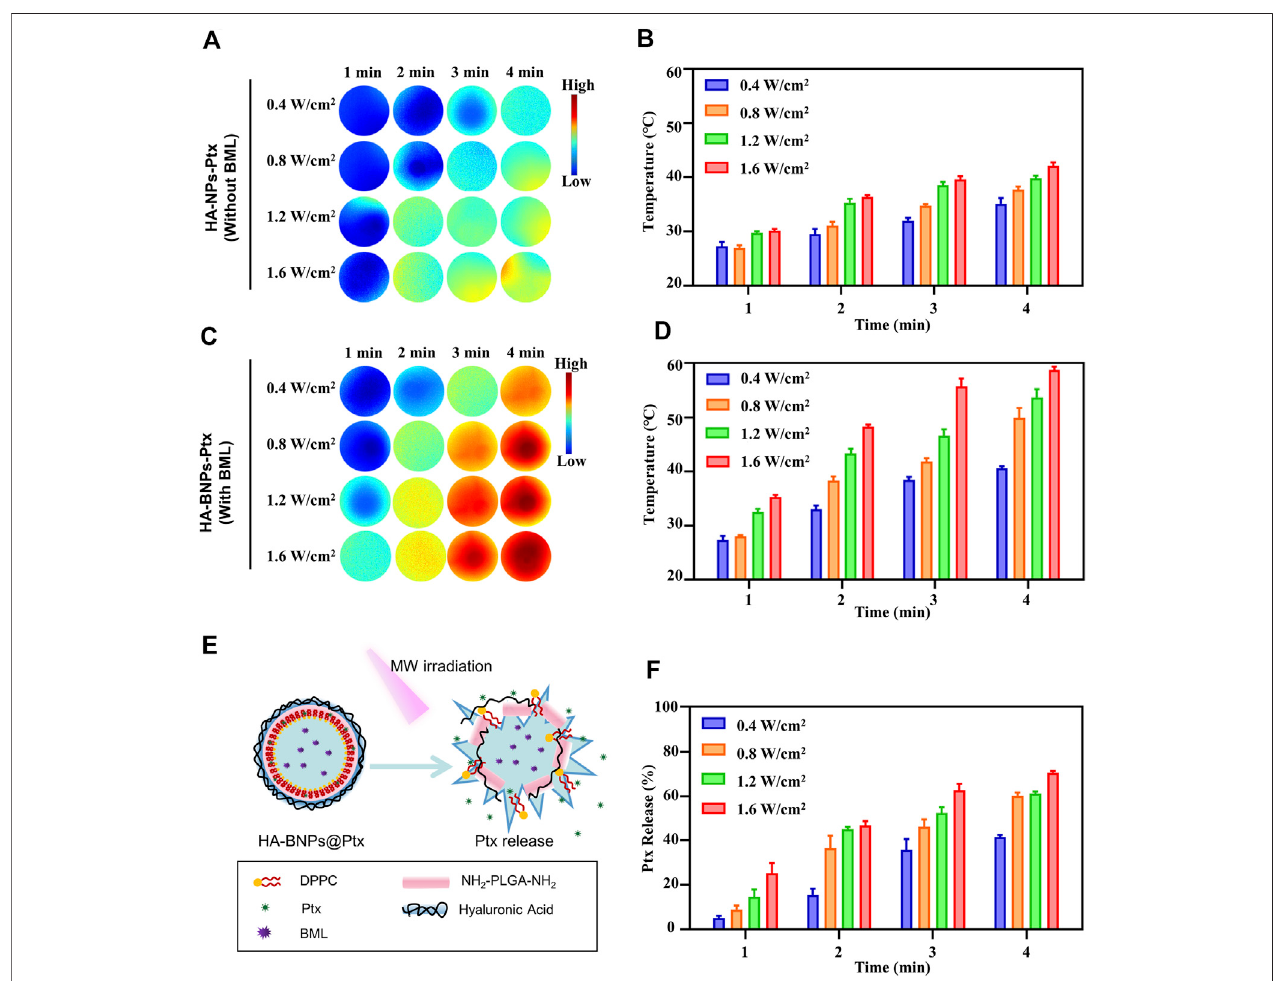
FIGURE 3 | In vitro evaluation ofmicrowave (MW) thermal effect and paclitaxel (Ptx) release. (A, B) IR thermal imaging and temperature histogram of HA-NPs@Ptx [without thermosensitive agent 1-butyl-3-methylimidazolium-L-lactate (BML)] at different MW power and exposure time. (C, D) IR thermal imaging and temperature histogram of HA-BNPs@Ptx (with thermosensitive agent BML). (E) Schematic illustration of HA-BNPs@Ptx BML activation and Ptx release under MW irradiation. (F) In vitro release of Ptx from HA-BNPs@Ptx exposed at different MW power and irradiation time. The data are presented as mean ± SD ( n (cid:2) 3).